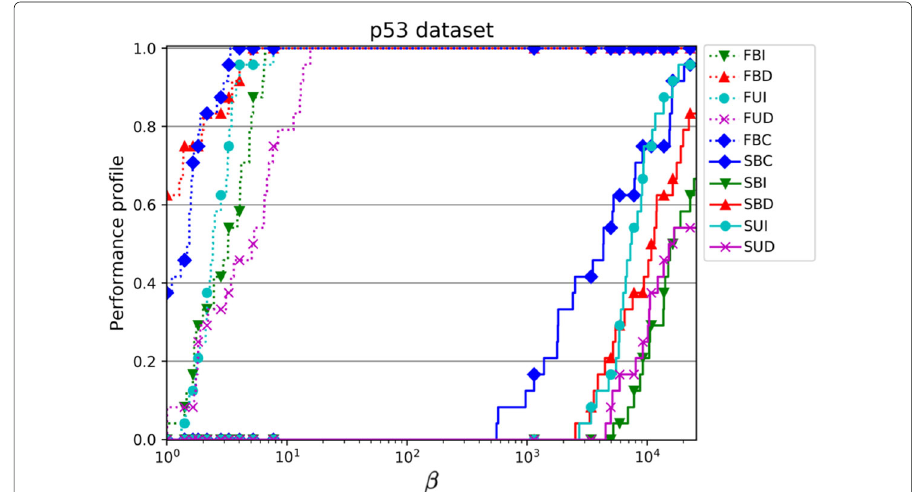
Fig. 14 Performance profile for all 10 methods, for the tests performed on the p53 data